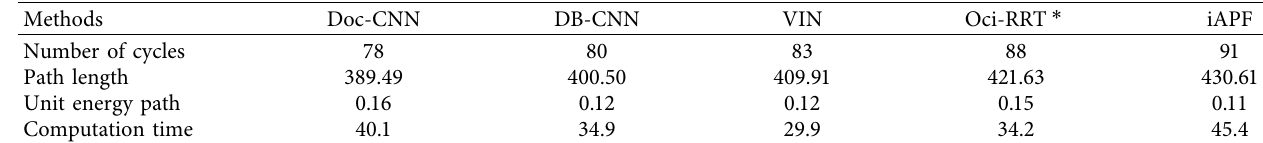
Figure 9: Compared to other algorithms. (a) Comparison of the path cycles. (b) Comparison of the path lengths. (c) Comparison of the unit energy paths. (d) Comparison of the computation times. Table 3: Comparison of experimental data of the five algorithms (average of 1000